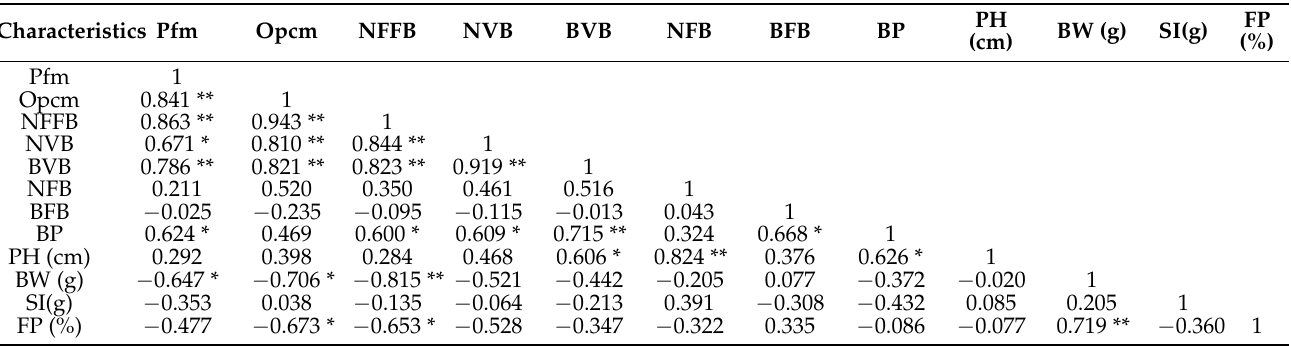
Table 6. Correlation coefficients between GCA effects on the traits of 12 cotton lines originated from Burkina Faso and the United